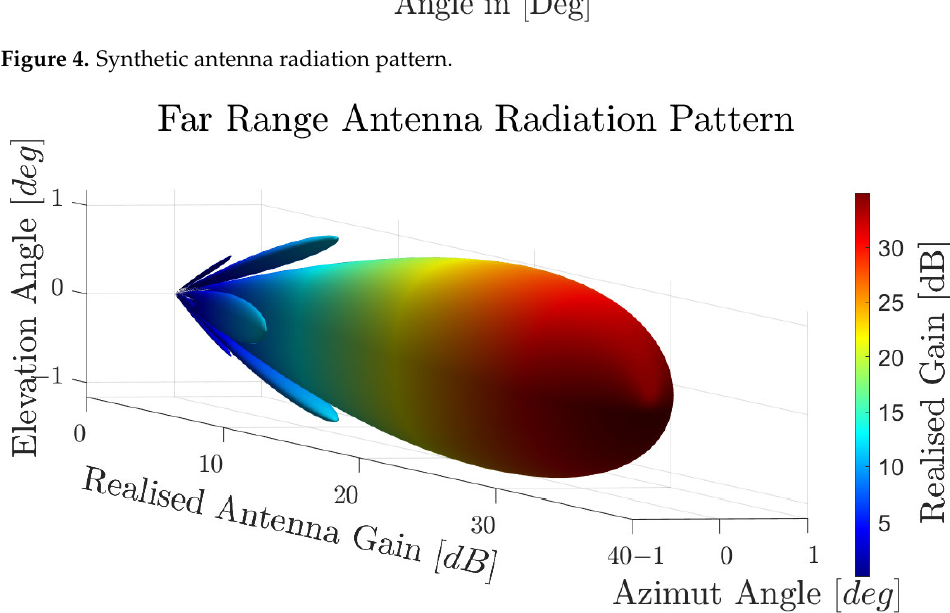
Figure 5. Synthetic antenna pattern in 3D